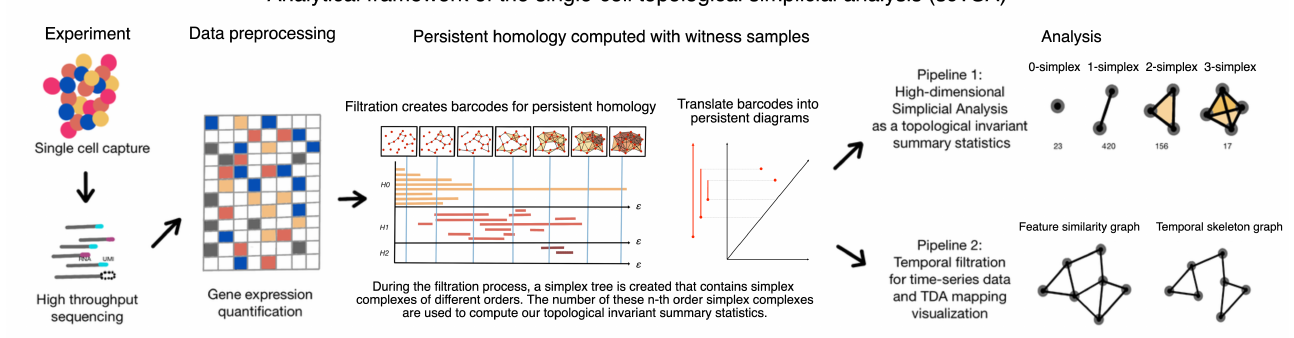
Figure 1. The analytical framework of the single-cell topological simplicial analysis (scTSA). The pipeline starts with the single-cell sequencing data, which are then preprocessed into gene expression profiles in a 2D matrix (rows are cells and columns are genes). This step can also go through another layer of dimension reduction. From the matrix, we compute the filtrations over their feature space and temporal constraints. The persistent homology can be computed from the filtration process with either a persistent barcode or a persistence diagram. The filtrations obtained through the processes can also be used for simplicial analysis, which groups the cells by time steps before the analysis. Finally, one can visualize the data using the Mapper algorithm with or without the temporal